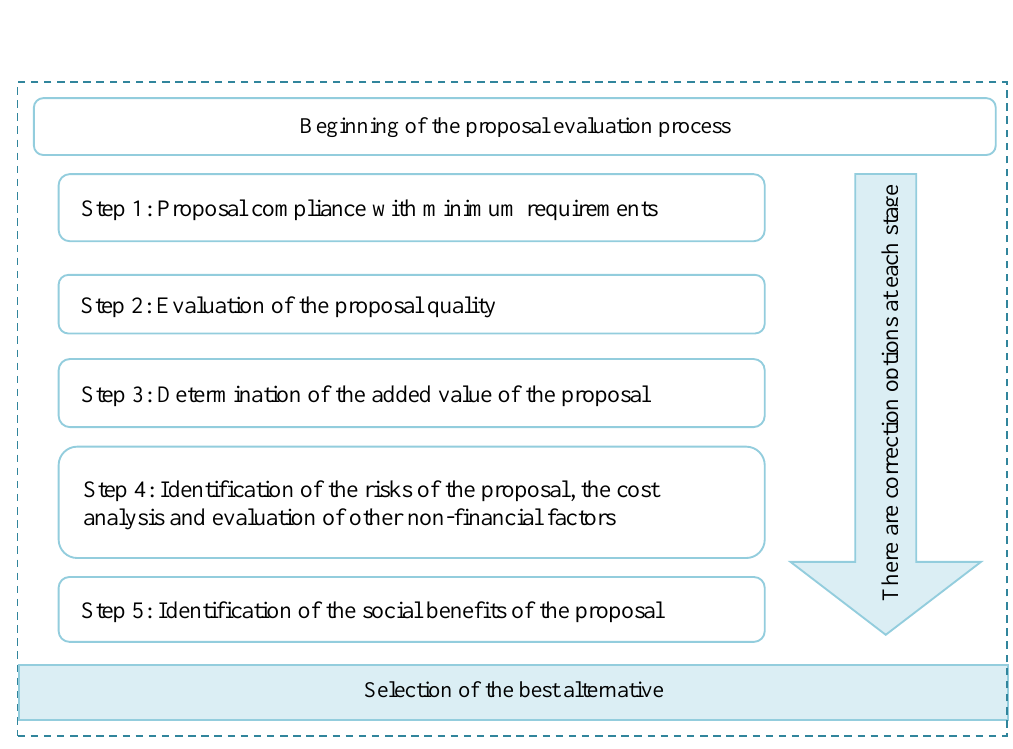
Fig. 4. Framework for the evaluation of innovation proposals (created by the